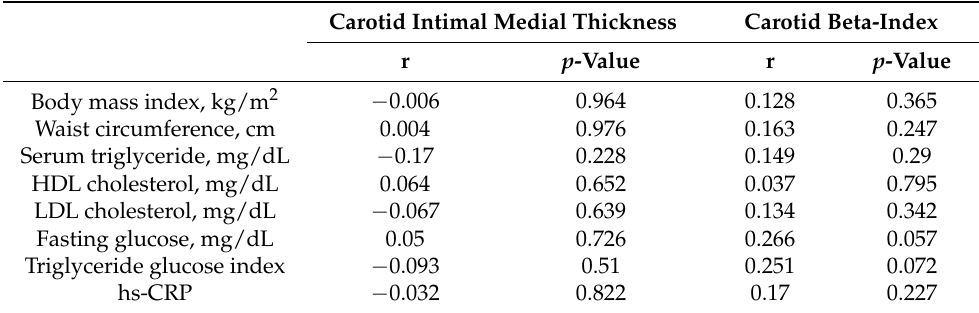
Table 4. Correlation between cardio-metabolic profiles and carotid intimal medial thickness and carotid beta-index in participants with FM. Carotid Intimal Medial